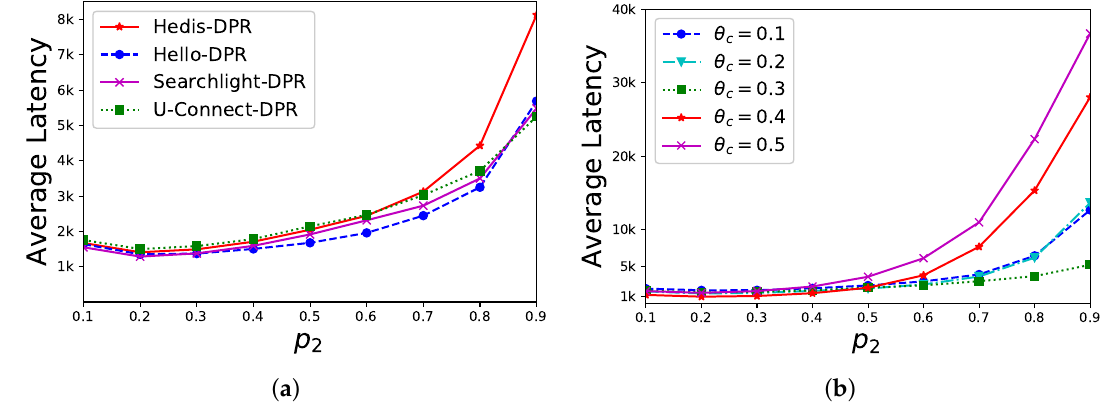
Figure 6. Sensitivity of p 2 in the DPR method. ( a ) θ c = 0.3; ( b )